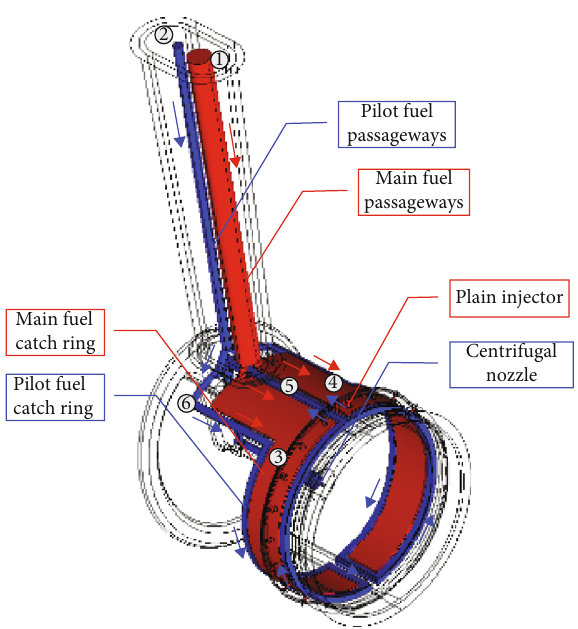
Figure 4: Fuel paths